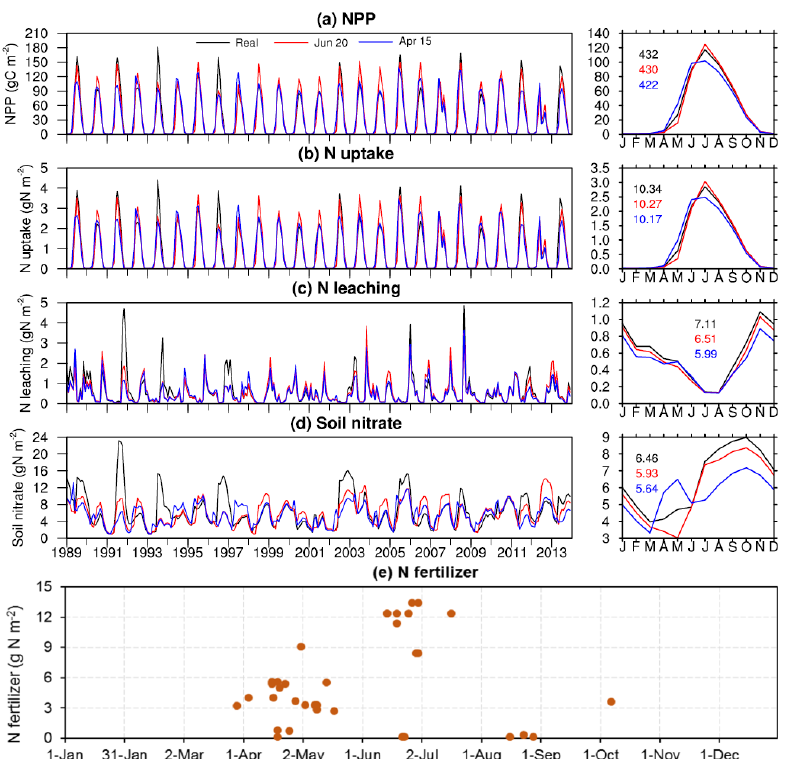
Figure 8. (left column) Monthly and (right column) climatologically seasonal cycle of model-simulated (a) NPP, (b) N uptake, (c) N leaching, and (d) soil nitrate with different dates for N fertilization: real, 20 June, and 15 April. The values in the right column indicate annual mean for each term (black: real; red: 20 June; blue: 15 April). (e) Actual nitrogen fertilizer application amounts and dates as recorded in the agronomic